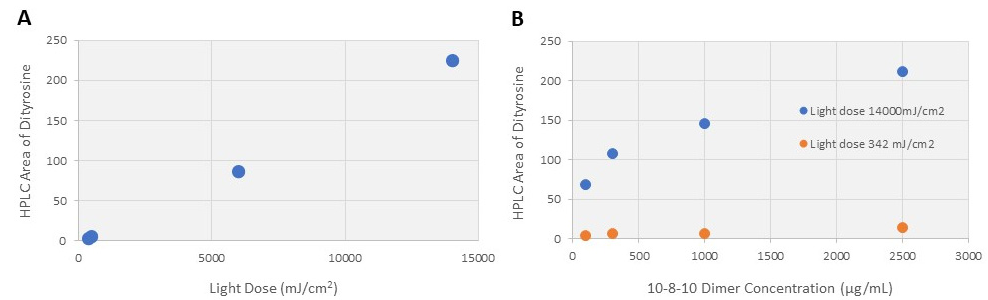
Figure 5. ( A ) Formation of dityrosine with varying light dose. 10-8-10 Dimer and model peptide concentrations were in excess and kept constant. ( B ) Formation of dityrosine as function of 10-8-10 Dimer concentration at 2 light doses.